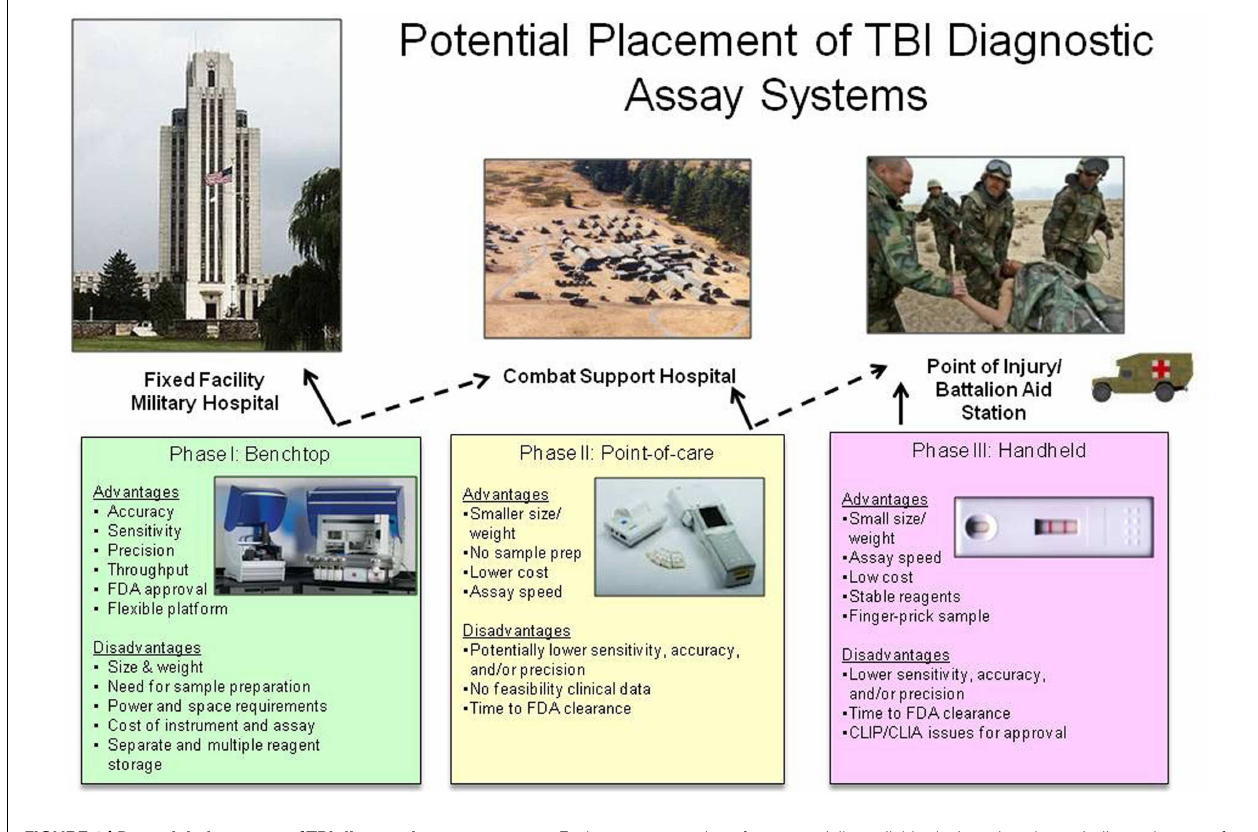
FIGURE 1 | Potential placement ofTBI diagnostic assay systems. Each potential device has advantages and disadvantages that constrain its use in the military medical system. Solid lines represent ideal placement of each system, dashed lines represent possible placement of each system depending on logistical support. All device pictures are representative